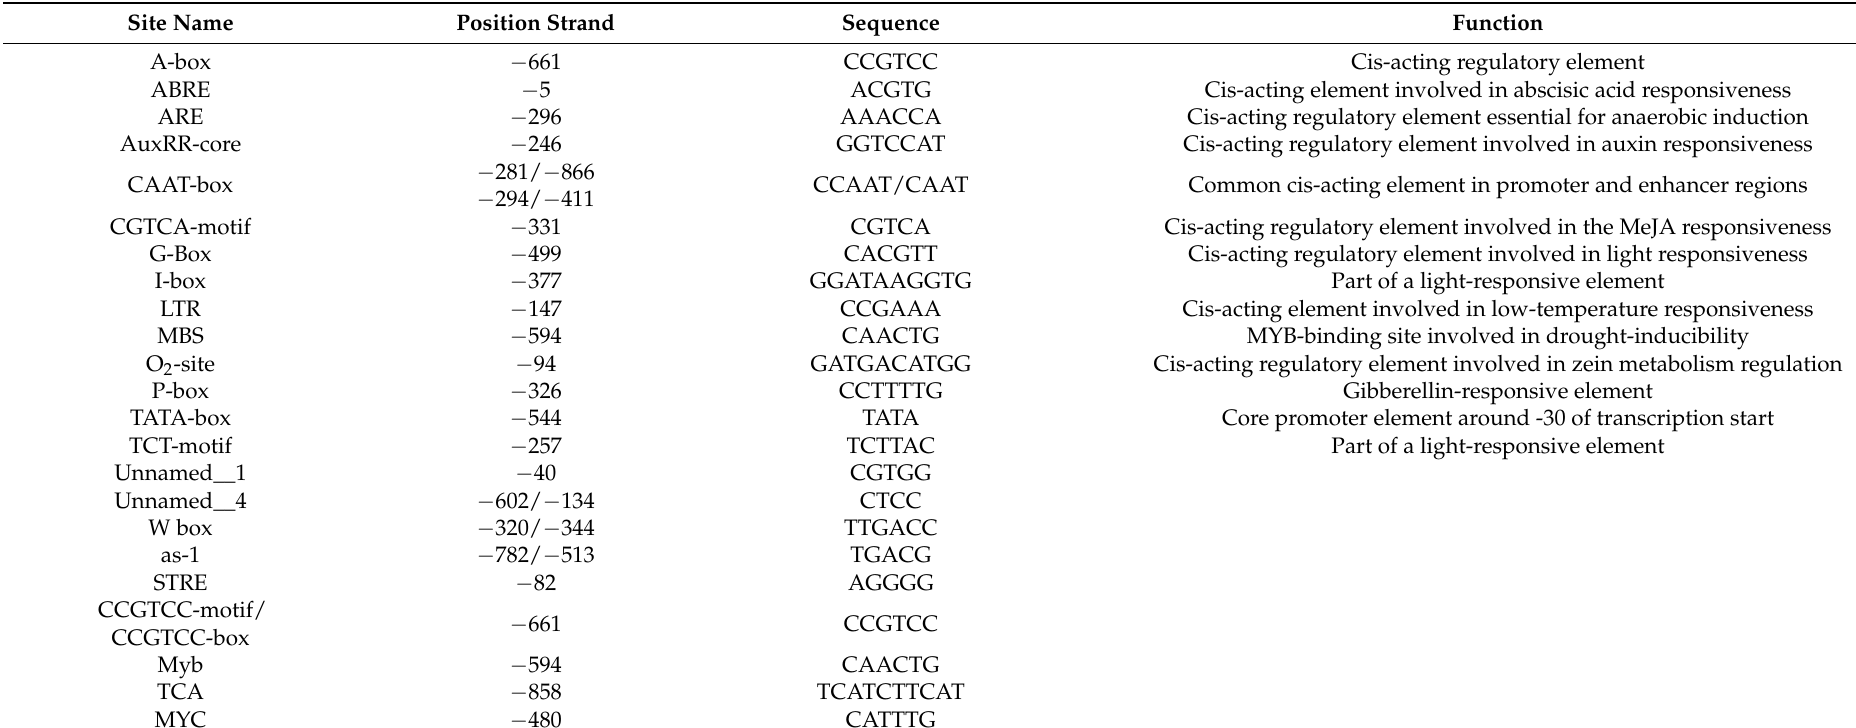
Table 2. Prediction of the cis-acting elements of the promoter region of the MrBBS gene in German